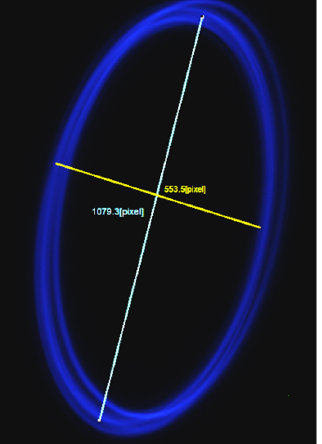
Figure 19. Front light image of the cantilever scan based on bridge having the shape of design